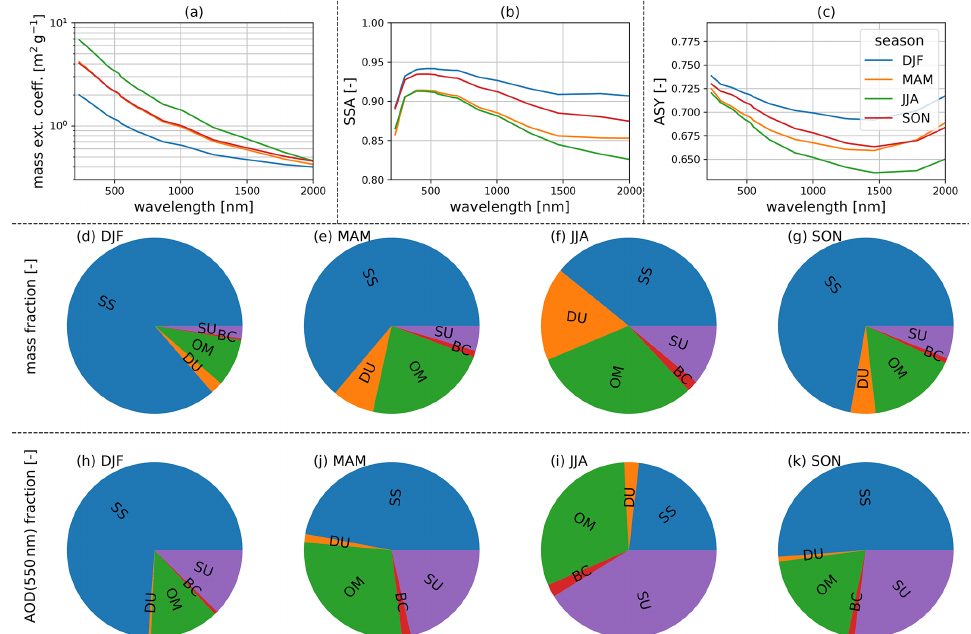
Figure 12. Seasonal mean of the mass extinction coefficient, single scattering albedo (SSA) and asymmetry parameter (ASY) (a–c) of the aerosol mixture (d–g) and (h–k) from the CAMS RA aerosol properties database over Germany 2015. The aerosol mixture pie charts show the column-integrated mass fraction of each aerosol classification (d–g) (see Bozzo et al., 2020a) and the contribution to the extinction by fraction of AOD at 550nm (h–k) (SS – sea salt; DU – mineral dust; OM – organic matter; BC – black carbon; SU – ammonium